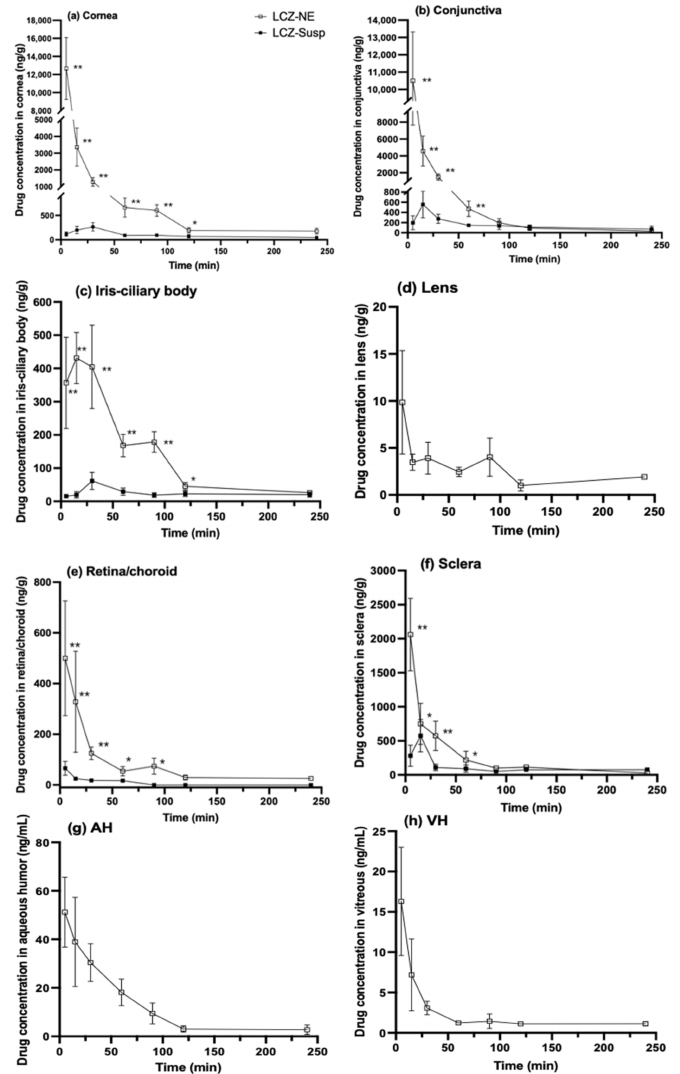
Figure 12. Concentration − time charts of LCZ in rabbit ( a ) cornea, ( b ) conjunctiva, ( c ) iris-ciliary body, ( d ) lens, ( e ) retina/choroid, ( f ) sclera, ( g ) AH and ( h ) VH after one topical application of the LCZ-NE and LCZ-Susp. Data represented as mean ± SD, n = 6; * p < 0.05, ** p < 0.01, compared to LCZ-Susp. (AH, aqueous humor; VH, vitreous humor. The drug levels in the lens, AH and VH of rabbit eyes in the LCZ-Susp group were